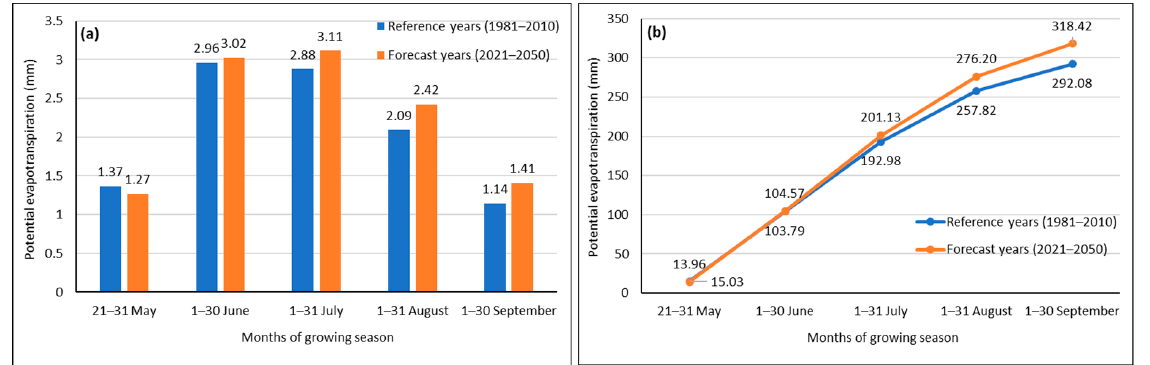
Figure 2. Jerusalem artichoke water needs, expressed as potential evapotranspiration, in the period of 21 May–30 September in the reference and forecast years presented as daily values in the particular months ( a ) and the cumulated sum curve ( b ).